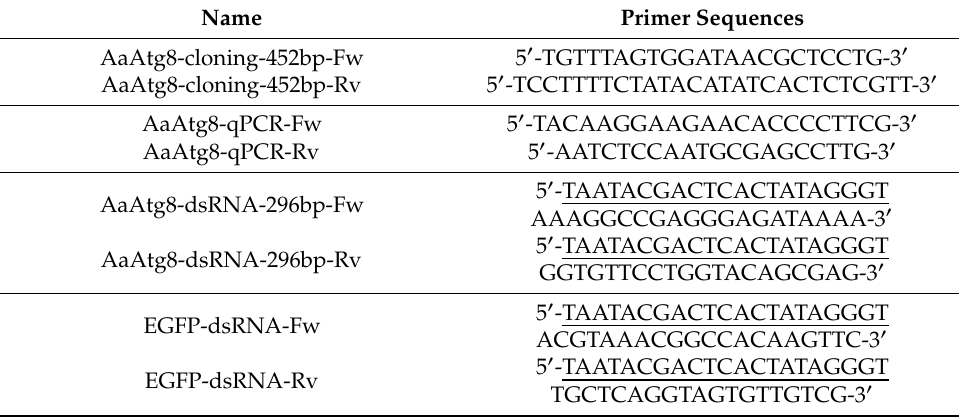
Table 1. Primer sequences used in the